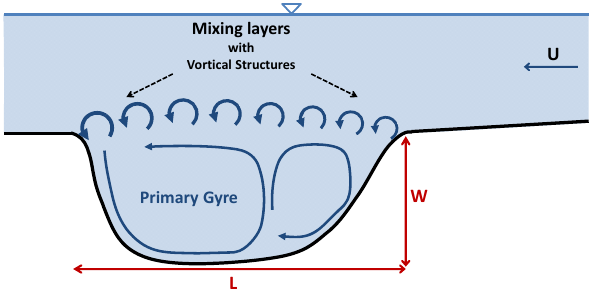
Fig. 10. Schematic of the flow field for a vertically submerged cav- ity. Gyre formation within the cavity is depicted for W/L< 0.5. Note that gyre formation in vertically submerged cavities is equiva- lent to lateral cavities at the same W/L (see Fig.